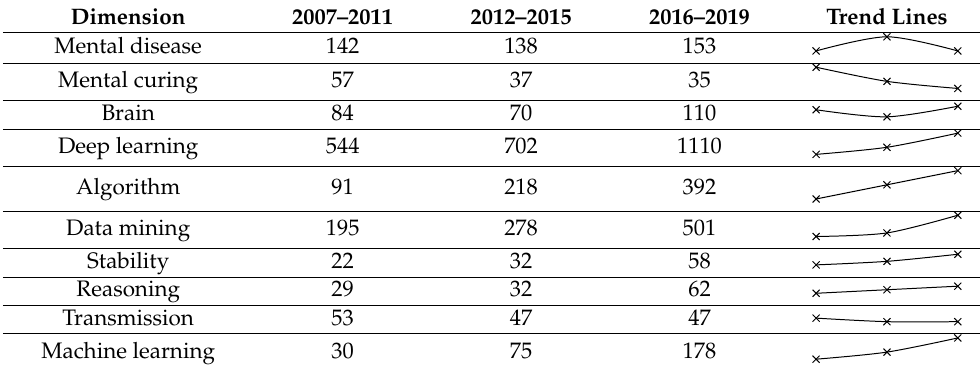
Table 4. Major dimensions and their corresponding